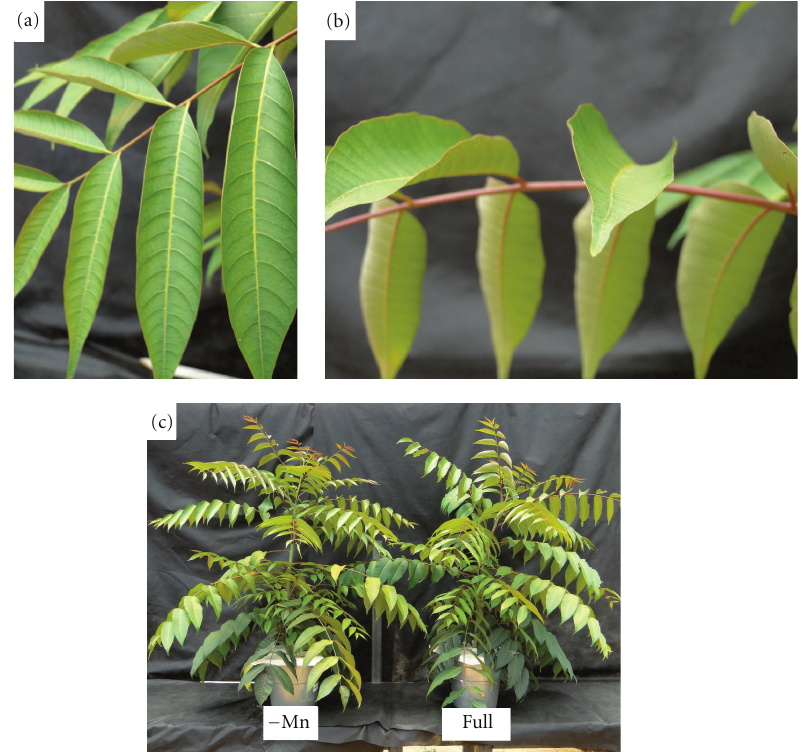
Figure 5: Symptoms of manganese deficiency in Australian Red Cedar seedlings. Bent leaves ((a) and (b)), and young leaves lighter in relation to the plants in the full treatment (c).